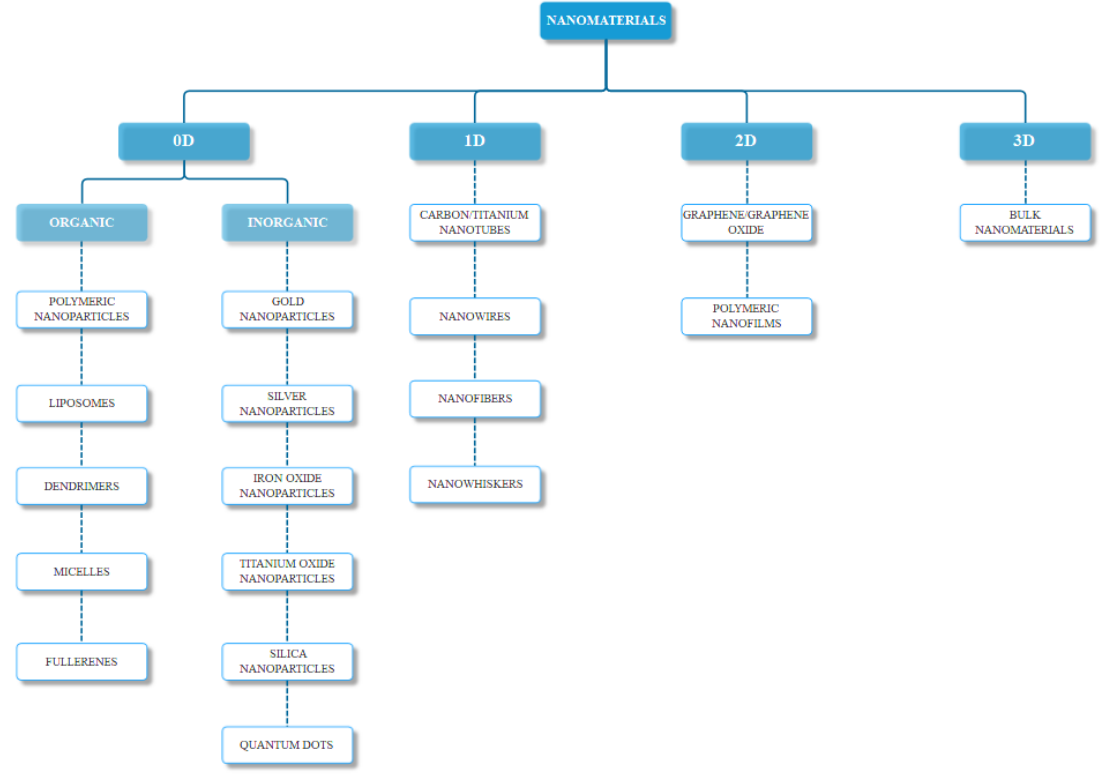
Figure 1. Nanomaterials classification based on their dimensionality (0D—zero-dimensional, 1D—one-dimensional, 2D—two-dimensional, 1D—one-dimensional, 2D—two-dimensional, 3D—three-dimensional).